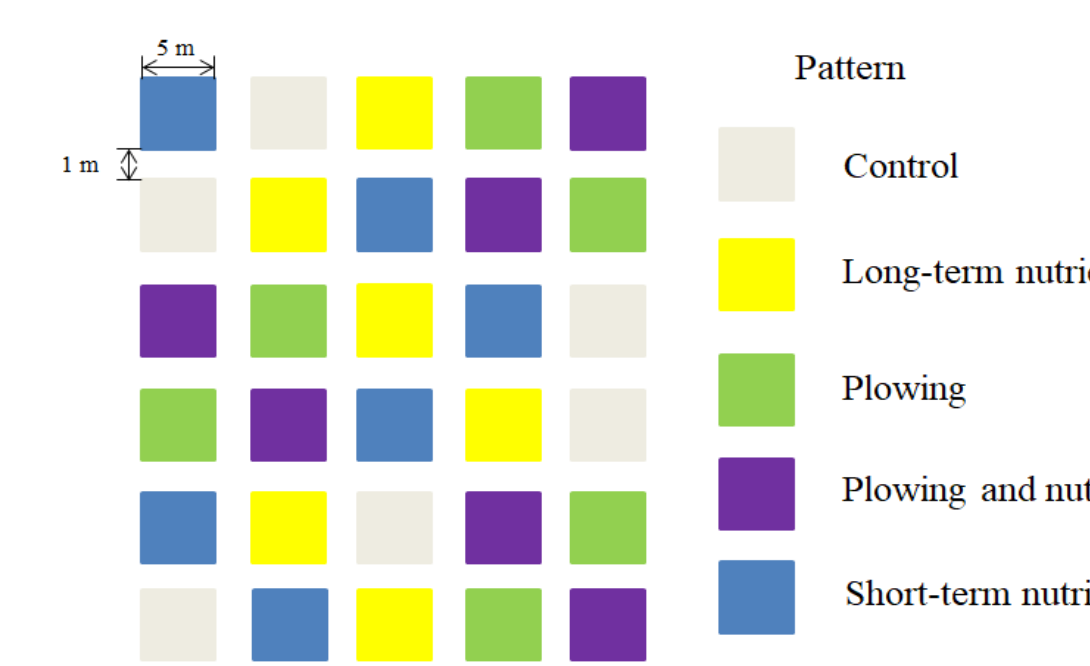
Figure 2. Schematic diagram of experimental design.